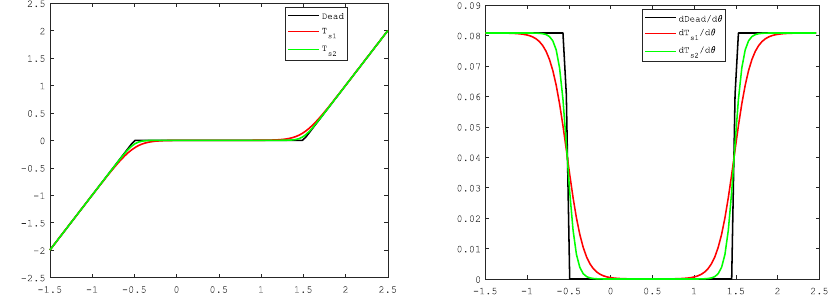
) ( ) ln( = 2, ∂ r = 1.5, ∂ = l k =  =  = . Figure 2. Dead-zone approximation: k r l